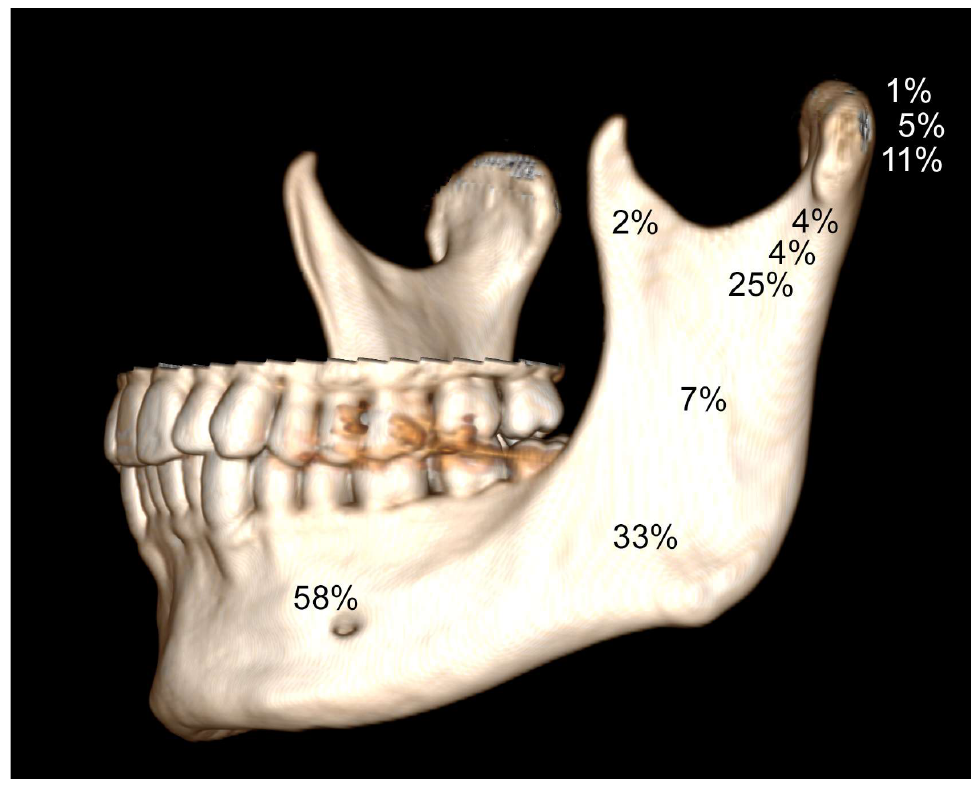
Figure 4. Frequencies of observed fractures of the mandible (as presented in Table 2). Data do not sum to 100% because there are multiple fractures in the included cohort. Table 2. Frequency of mandible fractures.